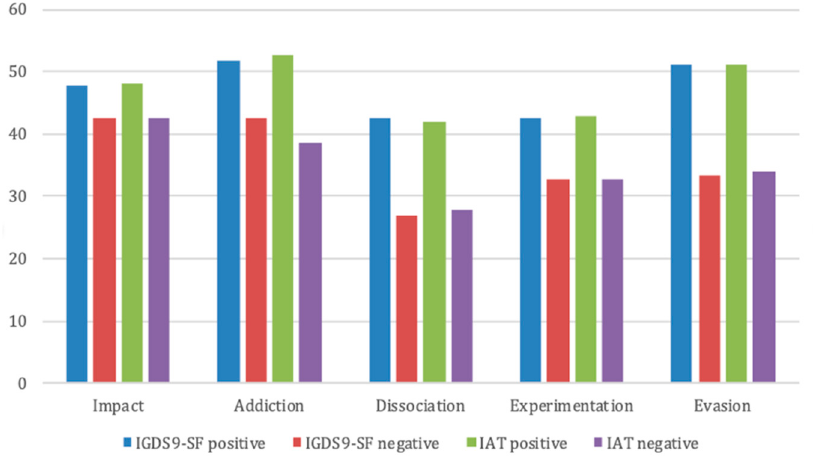
Figure 2. The figure shows the mean scores in the different subscales of the UADI in patients with scores below and above the cut-off at the IGDS9-SF and at the IAT. The clinical cut-off score for the UADI subscales is 50.